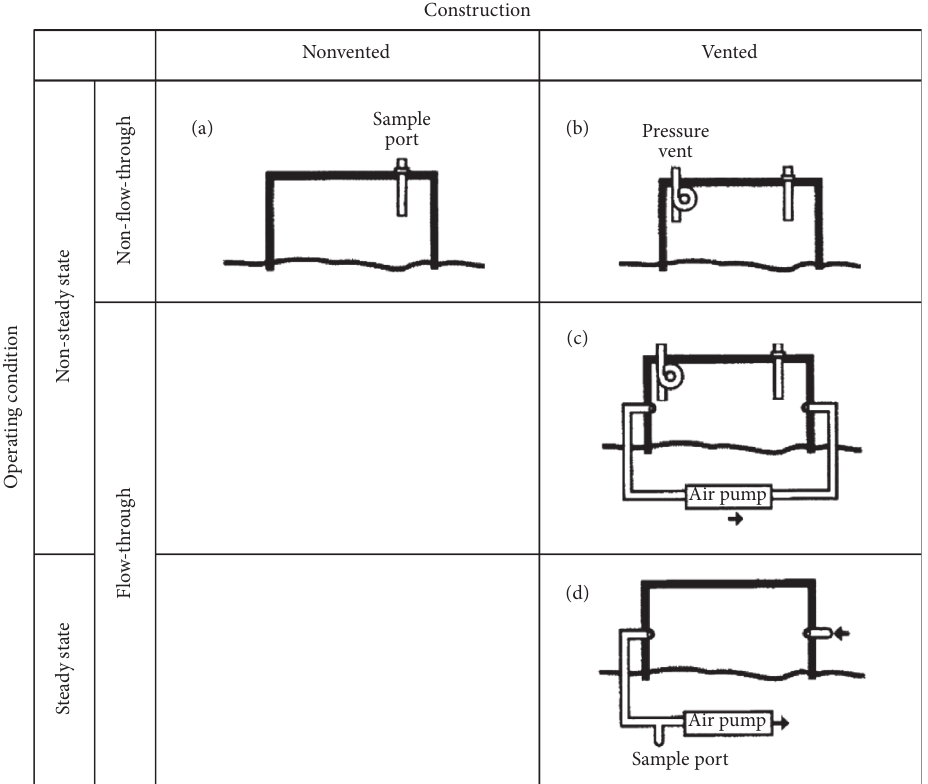
Figure 1: Chambers classification by Matson and Harriss